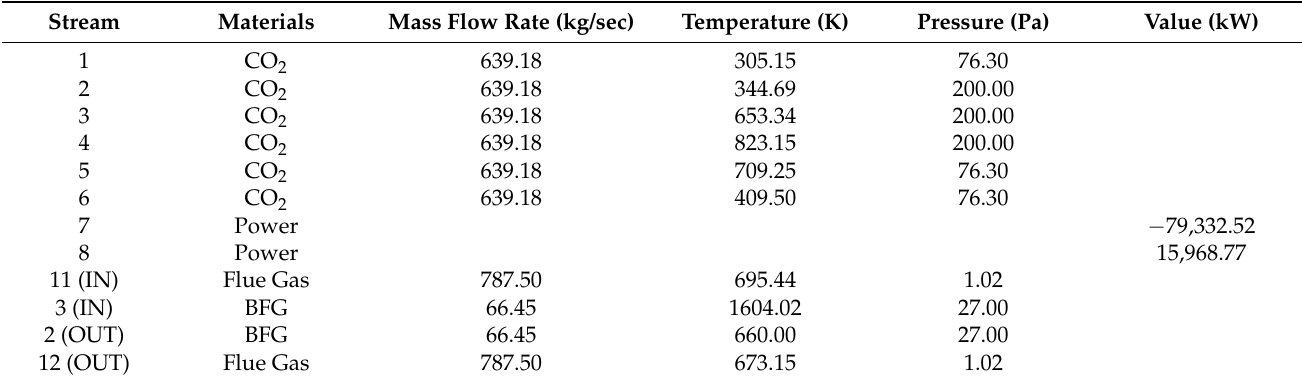
Table 9. Stream parameters in BRAYT.